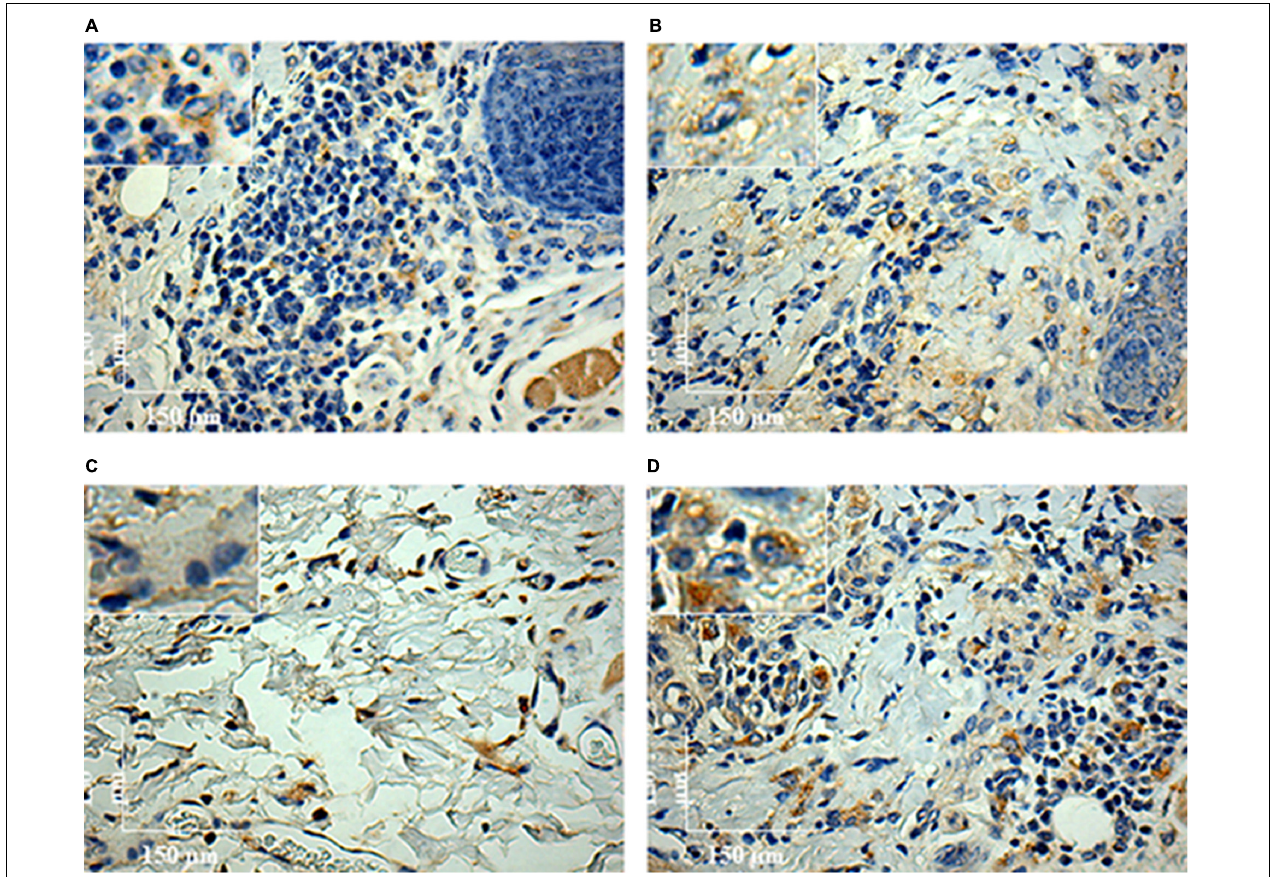
FIGURE 8 | Immunohistochemistry (IHC) using anti-CD163 mAb of C. porcellus infected with L. enriettii (L88 and Cobaia) strains in the absence/presence of salivary gland extract (SGE). In the absence of SGE, L88-infected animals exhibited an intense CD163 positive cells staining (A) than in the presence (B) of SGE at 4 weeks PI. In the absence of SGE, Cobaia-infected animals exhibited a lower CD163 positive cells staining (C) than in the presence of SGE (D) at 6 weeks PI. Amplified areas in the upper left side showing macrophage